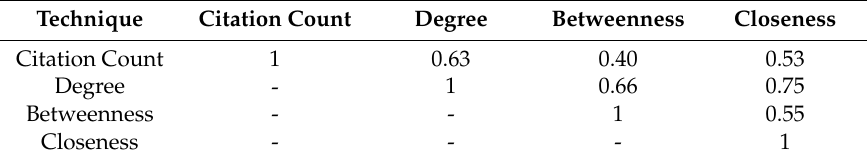
Table 12. OSim between degree, betweenness, closeness and citation